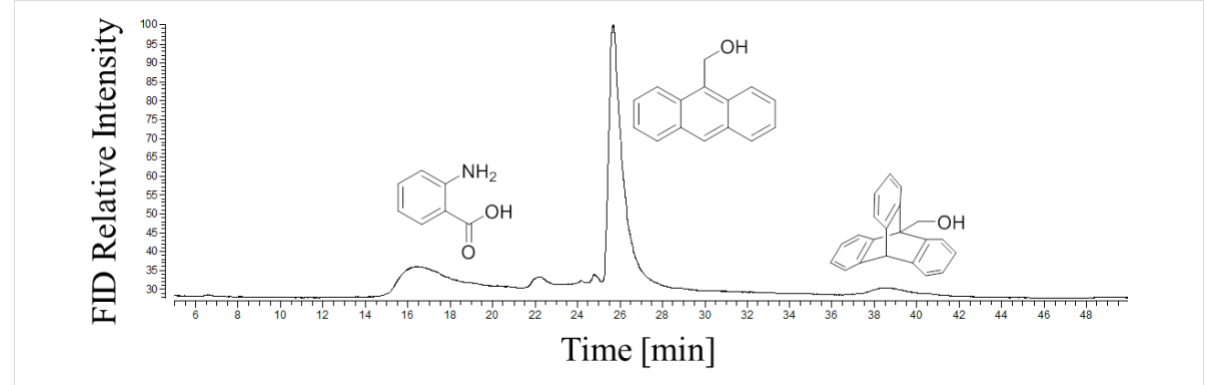
Figure 3: Experimental ocRGC chromatogram of 9-anthracenemethanol with benzenediazonium-2-carboxylate. Conditions: on-column cold injection, 60 °C for 5 min, then 6 °C/ min to 180 °C, 120 kPa He; pre-column: fused silica, 10 cm, 250 nm film thickness, 250 µm i.d.; separation column: